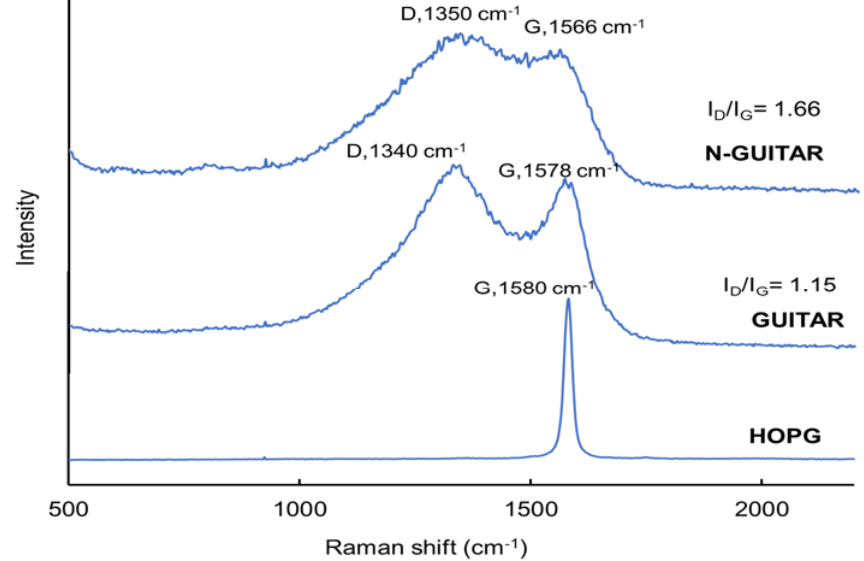
Figure 4. Raman spectra for N-GUITAR, GUITAR and HOPG taken with a 532 nm